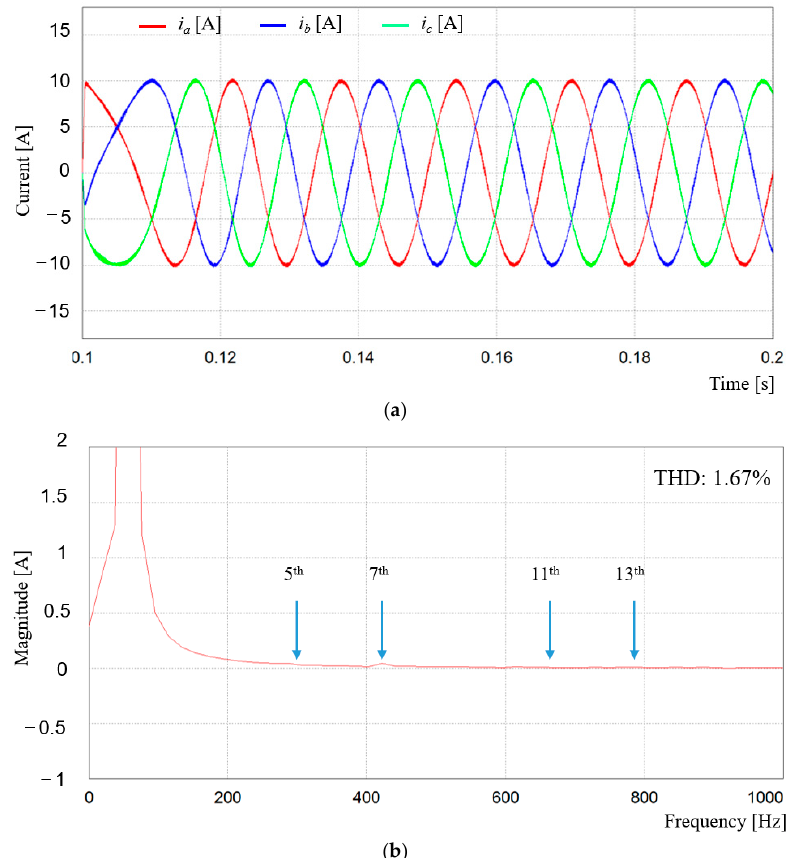
Figure 8. Inverter currents of the proposed control scheme consisting of the FCS-MPC with MAF. ( a ) Phase currents; ( b ) FFT result of a -phase current.